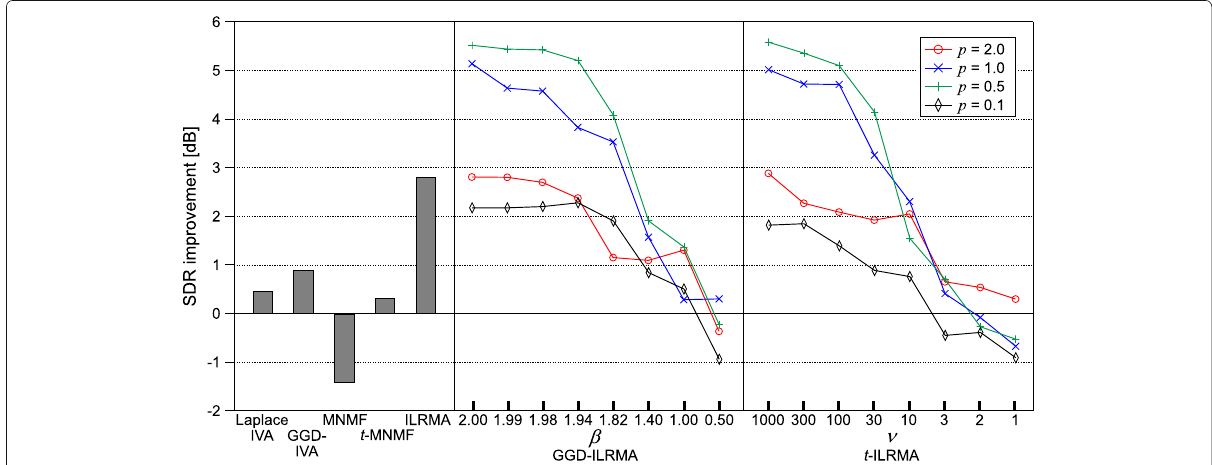
Fig. 12 Average SDR improvements of Music 3 with E2A_2 signal using fixed parameters. The results for GGD-IVA and t -MNMF using β = 0.5 and ν = 30 are shown, which are their best parameter